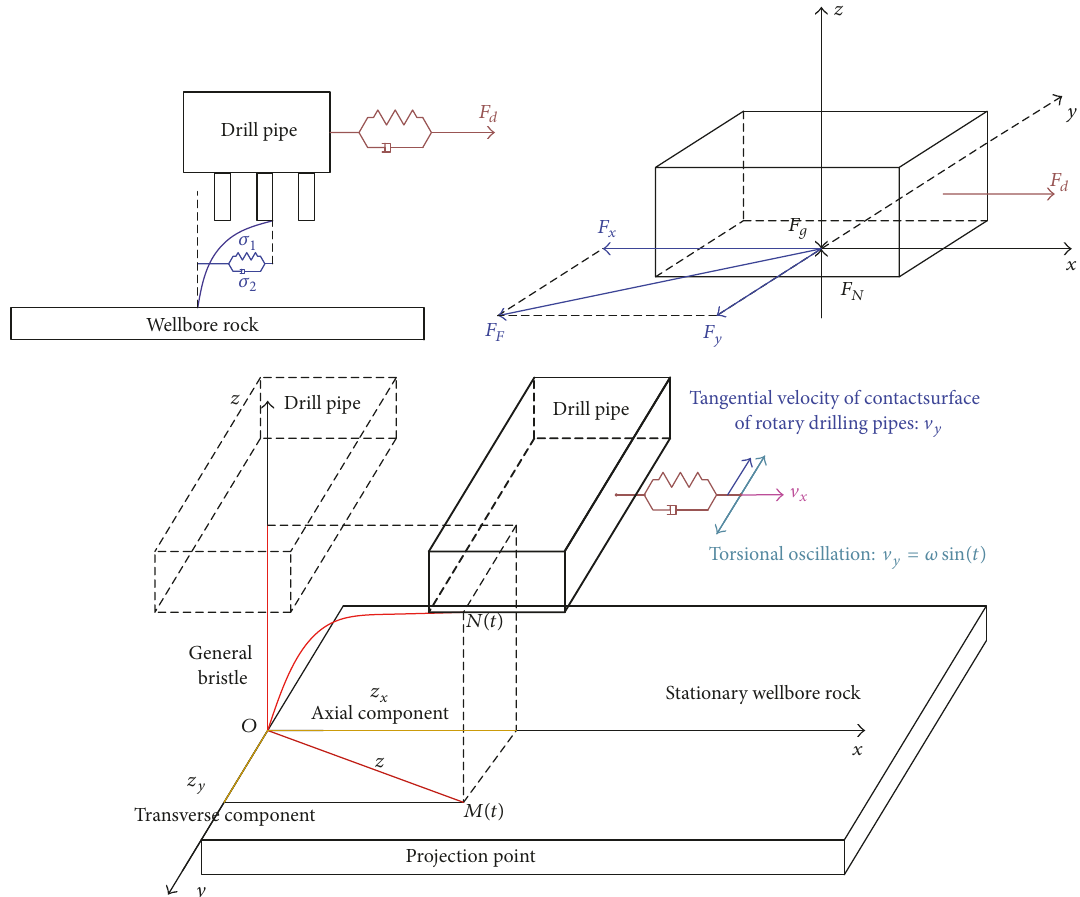
Figure 3: Distribution of forces acting on the sliding and torsional oscillation of the drill string.